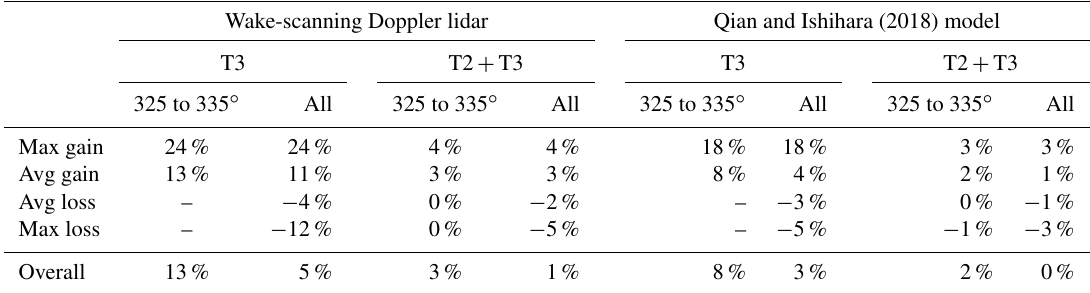
Table 3. Maximum and average power gains and losses due to wake steering for the subgroup with wind directions between 325 and 335 ◦ and considering all wind directions. The two left columns show the power changes based on the wake-scanning lidar; the two right columns show the power changes based on the Qian and Ishihara (2018) model. The results of the downwind turbine (T3) and the combined system of upwind and downwind turbines (T2 + T3) are shown for both. The percentage values are based on the power of the yawed case. Data of the wake-steering cases with a 3D scan of wake-scanning lidar and a model prediction at x/D = 4 are